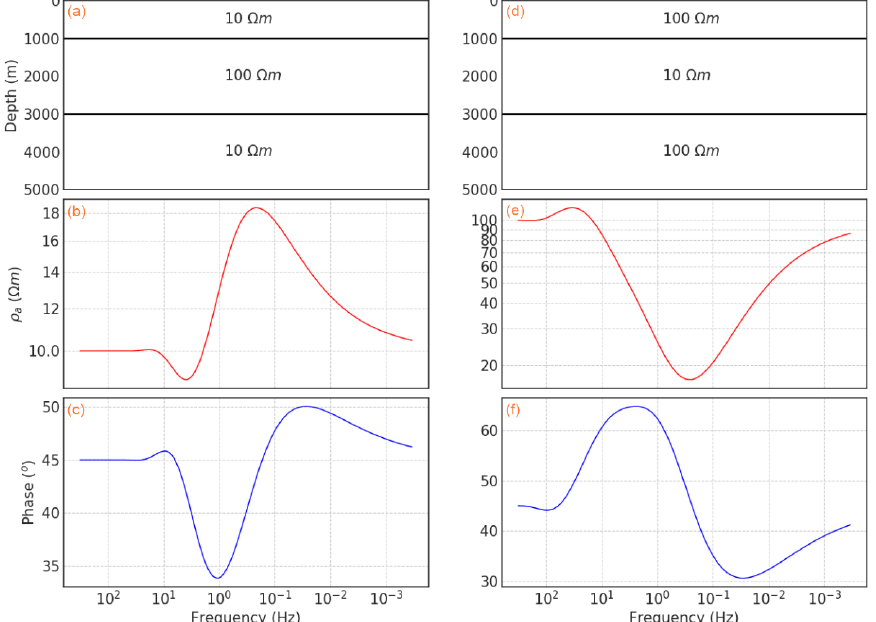
Figure 1. Synthetic model parameters ( a , d ) and its forward model curves showing the variation of apparent resistivity ( b , e ) and phase ( c , f ) on the Earth’s surface.